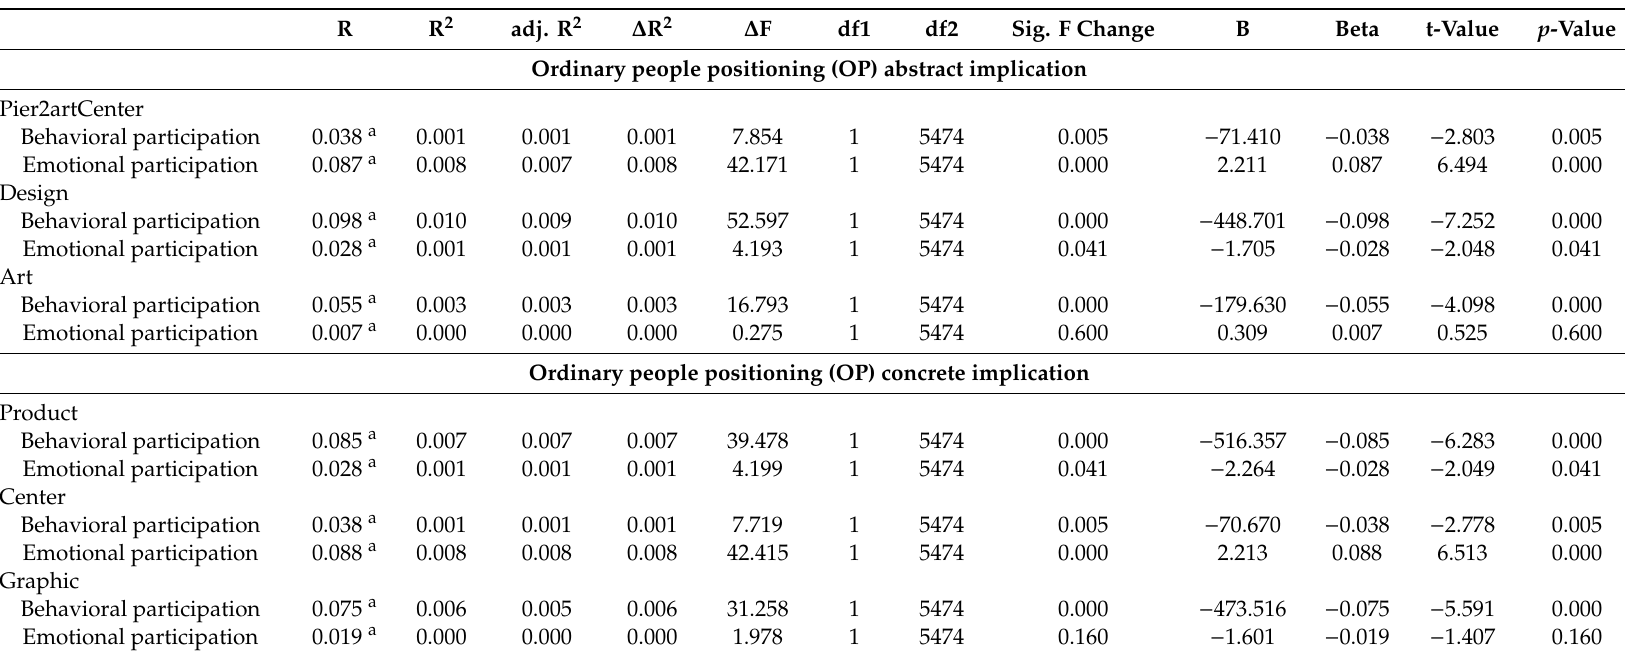
Table A6. Linear regression coe ffi cient of determination and beta (ordinary people positioning